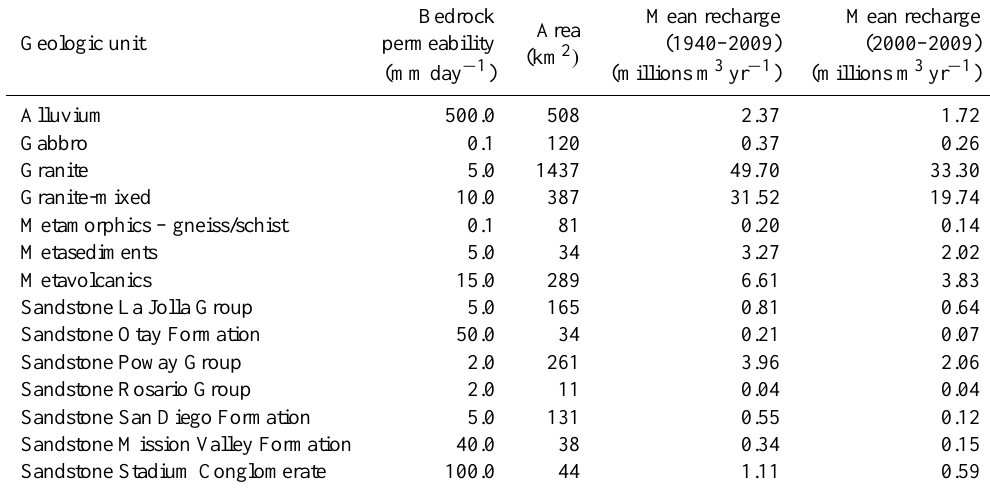
Table 4. Average annual recharge calculated using the Basin Characterization Model for geologic units in the San Diego region.